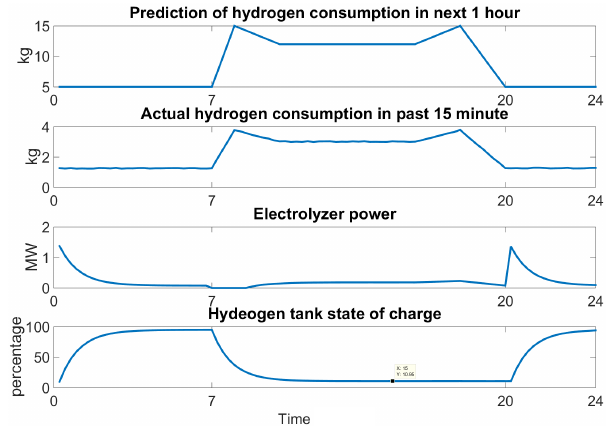
Figure 14. Case study: slow-loop optimization effect on electrolyzer